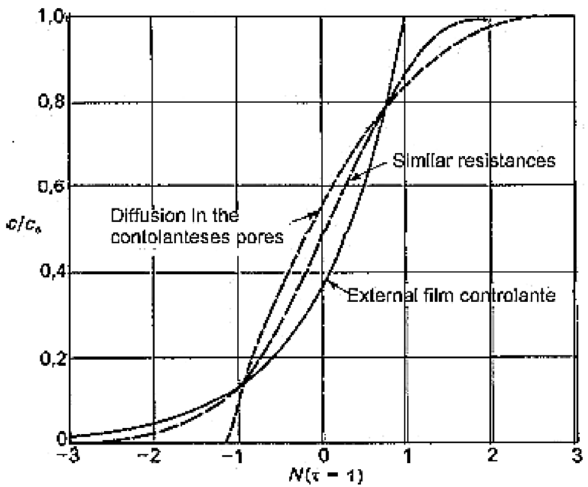
Fig. 1 Breakthrough curves for irreversible